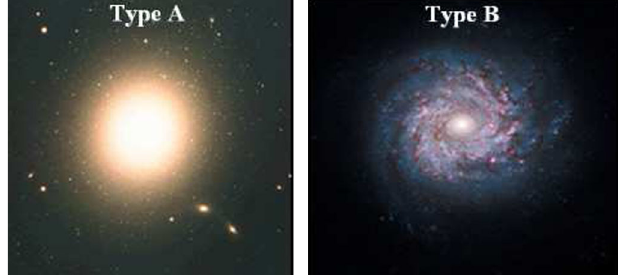
FIG. 4. Elliptical galaxy (type A) and Spiral galaxy (type B). Following open-ended questions were asked: The photographs show two different types of galaxy. Why do you think their colors look different?; and, Why do you think they have different shapes?